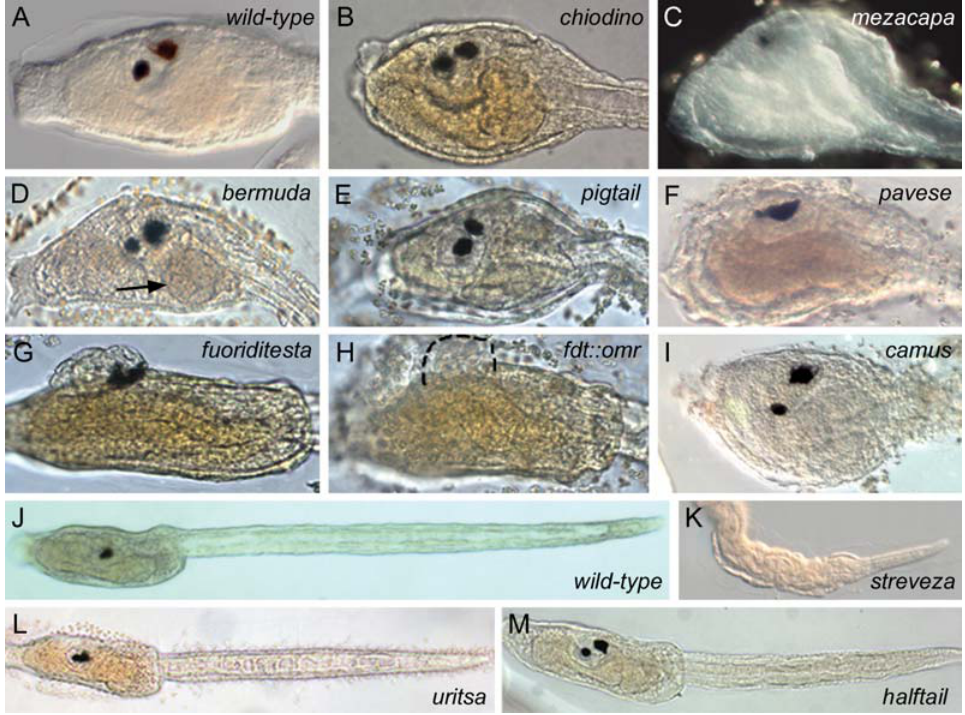
Figure 2. Examples of trunk, tail and multiple phenotypes. (A,B) Compared to the wild-type, the trunk and papillae of chiodino are smaller. (C) Anterior trunk and papillae do not form in mezacapa . (D) An endodermal structure is observed in bermuda that resembles a premature organ rudiment (black arrow). (E,F) The trunk is smaller in the multiple phenotype pigtail and pavese mutations. (G) fuoriditesta ( fdt ) is another multiple phenotype featuring a shorter tail (not shown) and an externalised sensory vesicle (white arrow). (H) fdt was originally isolated in a double heterozygosity carrier of fdt and omero mutations (see Figure 1) (dashed line delimits the sensory vesicle in double homozygous mutant larvae). (I) Massive cell death is observed across the body of camus larvae, as shown by the trunk. (J–M) Compared with wild-type larvae, some mutations display tails that are shorter than normal (L). The morphology of the notochord cells in the tails of halftail and streveza homozygous larvae suggests an impaired differentiation